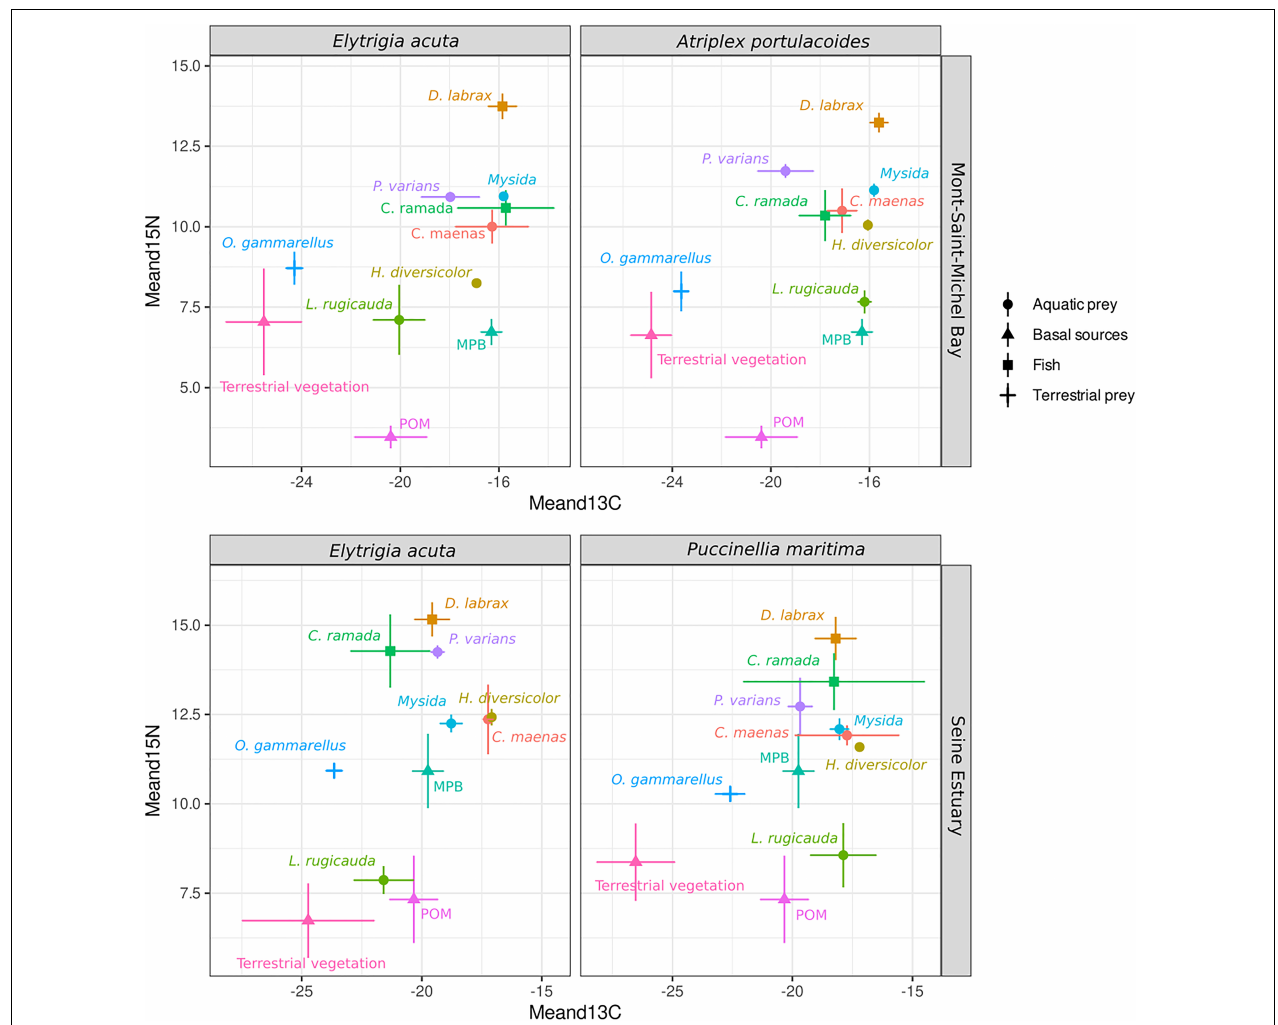
FIGURE 2 | Biplots presenting the mean and standard deviation of isotopic values ( δ 13 C and δ 15 N) of fish, their prey and basal resources for each site and marsh-plain type ( Elytrigia acuta , Atriplex portulacoides , Puccinellia maritima ). Note, the prey and basal resources in the models are without marsh-plain type effects, the values presented are means per